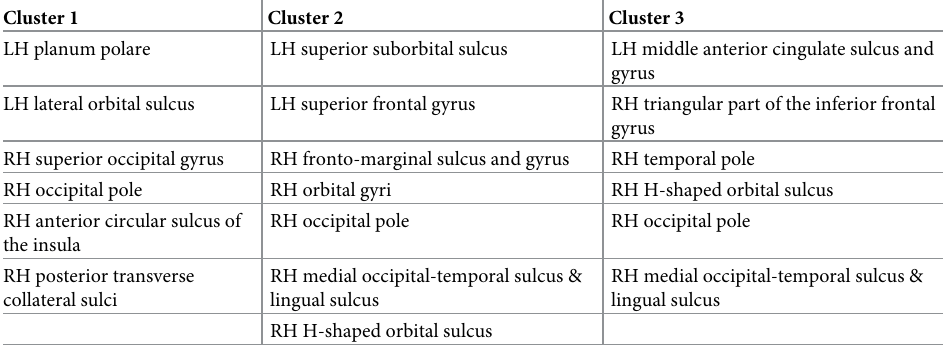
Fig 5. Functional data analysis curves for gyrification networks. Mean gyrification network coefficients for neurocognitive clusters plotted as a function of density. Cluster comparisons and p-values are derived from results of the Functional Data Analysis. Sigma = small-world. https://doi.org/10.1371/journal.pone.0218201.g005 Table 6. Gyrification network hubs defined by node